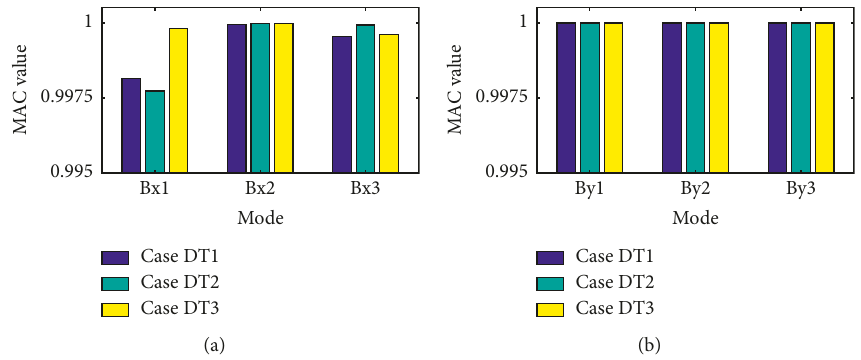
Figure 17: Modal assurance criterion (MAC) of mode shapes: damage type 1. (a) Along-wave modes. (b) Across-wave modes.